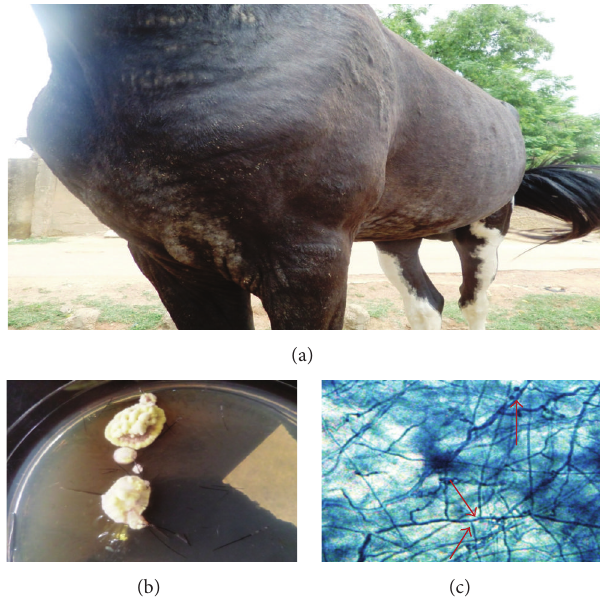
Figure 7: Areas of hyperkeratosis and alopecia caused by T. suda- nense (a), yellow to apricot heaped granular colony of T. sudanense (b), and few globuse microconidia with right angle branching hyphae (c) (LCB × 400).